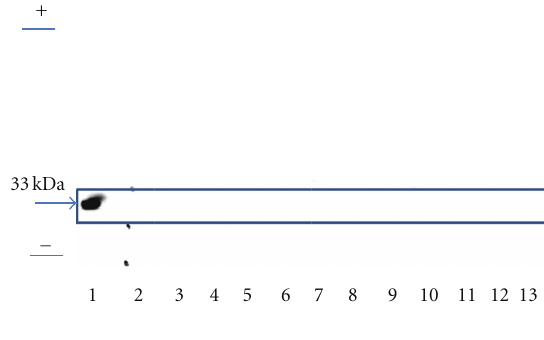
Figure 3: Representative Western blot with a polyclonal antibody directed against PA28 in BAL supernatant of twelve patients with ARDS. PA28 protein could not be detected in the BAL supernatant of ARDS patients. Start and front of the gel were marked as + and − . Lanes are identified as follows: Lane 1: 1 μ g PA28 (standard); Lane 2–13 BAL supernatant of twelve ARDS patients.